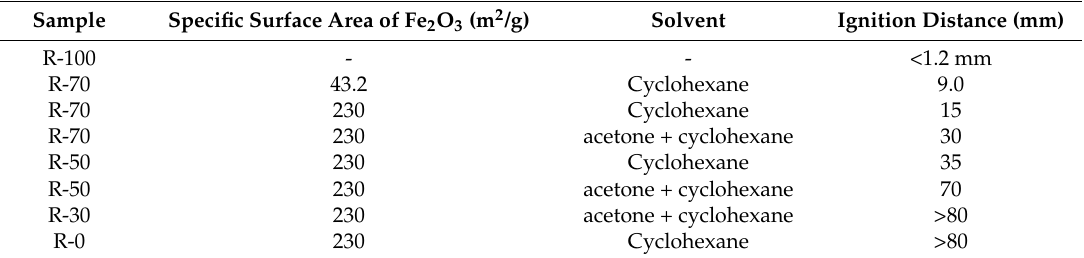
Table 3. Flame sensitivity of Al/Fe 2 O 3 /RDX nanocomposites.